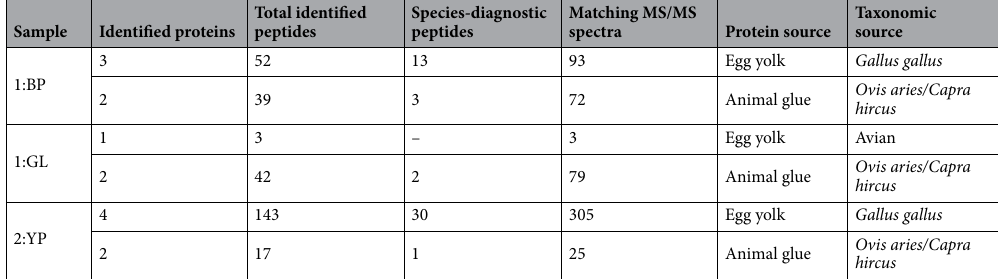
Table 2. Summary of the protein identifications for the micro-samples collected from “The Virgin and Child with Saint John and an Angel” (NG275).